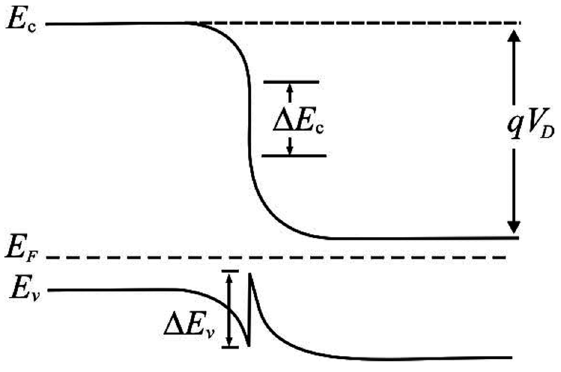
Figure 3. Energy band diagram of the ZnO on type IIb diamond heterojunction.